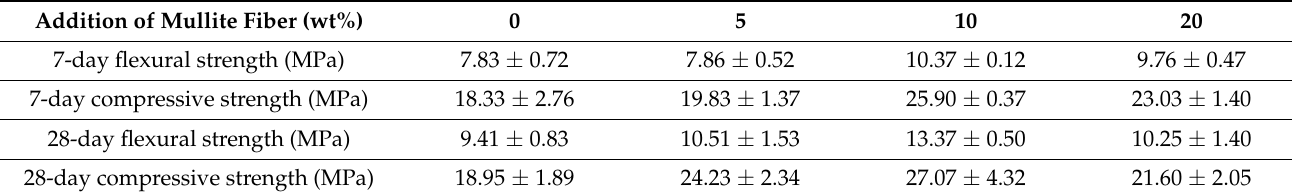
Table A1. Mechanical properties of geopolymer samples.